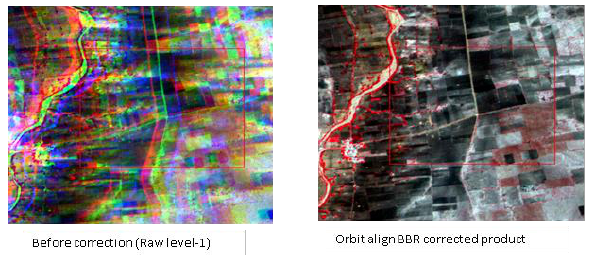
Figure 15. Band to band registration (before and after residual attitude